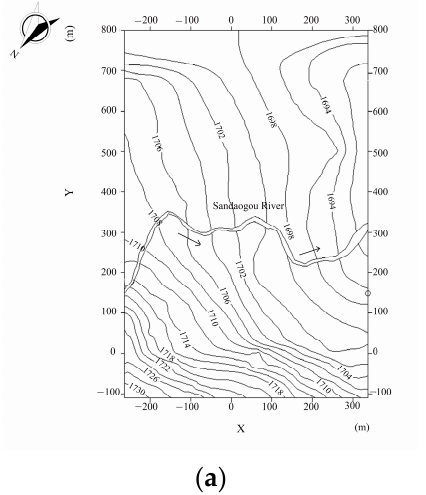
Figure 8. Results of the Hami concrete-face rockfill dam’s three-dimensional seepage field in the natural period. ( a ) Contour map of groundwater. ( b ) Three-dimensional seepage field.